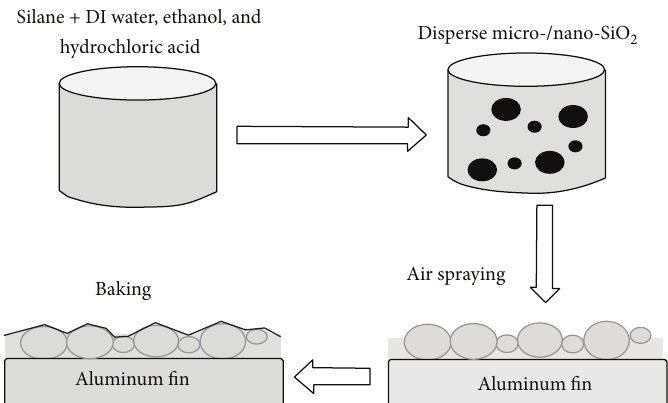
Figure 1: Illustration of surface modification